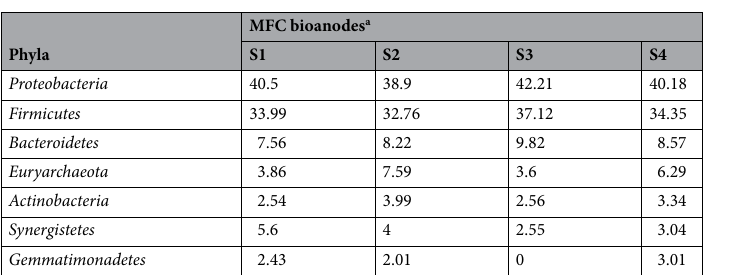
Table 1. Relative abundance (%) of the most prevalent bacterial phyla in the anodic biofilm. a Graphite-based anodes used were as follows. S1: control (no coating); S2: composite suspension of plant powder and rGO; S3: composite suspension of plant powder and PANI; S4: composite suspension of plant powder and